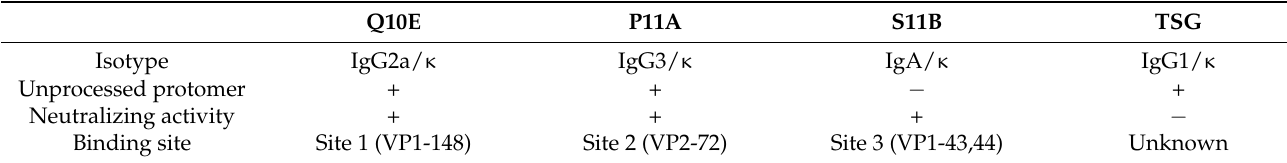
Table 1. Characterization of four anti-FMDV capsid monoclonal antibodies.